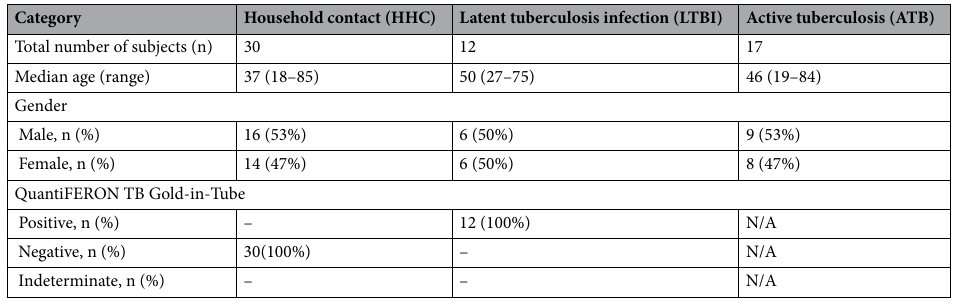
Table 3. Characteristics of subjects for cell-mediated immune response